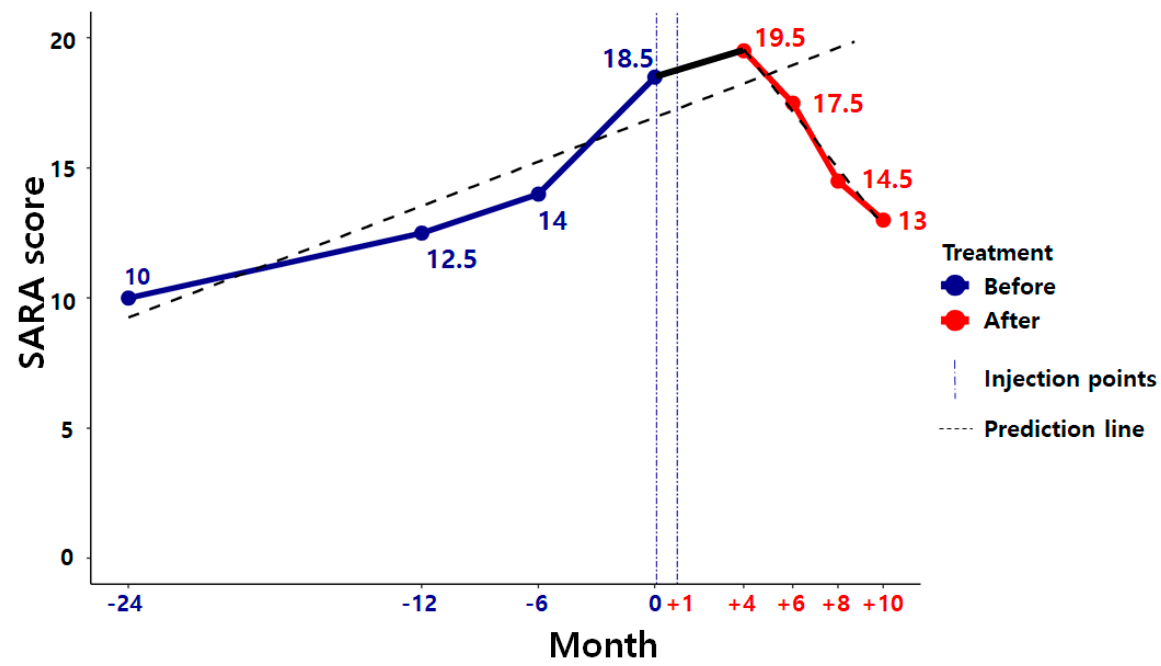
Figure 1. Line graph of the Korean version of the Scale for the Assessment and Rating of Ataxia (K-SARA) before and after the administration of the stem cell. K-SARA scores at the beginning of the stem cell administration had gradually deteriorated since the initial diagnosis (blue line) but showed a significant improvement up until 10 months (red line) following the completion of the second stem cell administration, contrary to the predicted line (black dot).